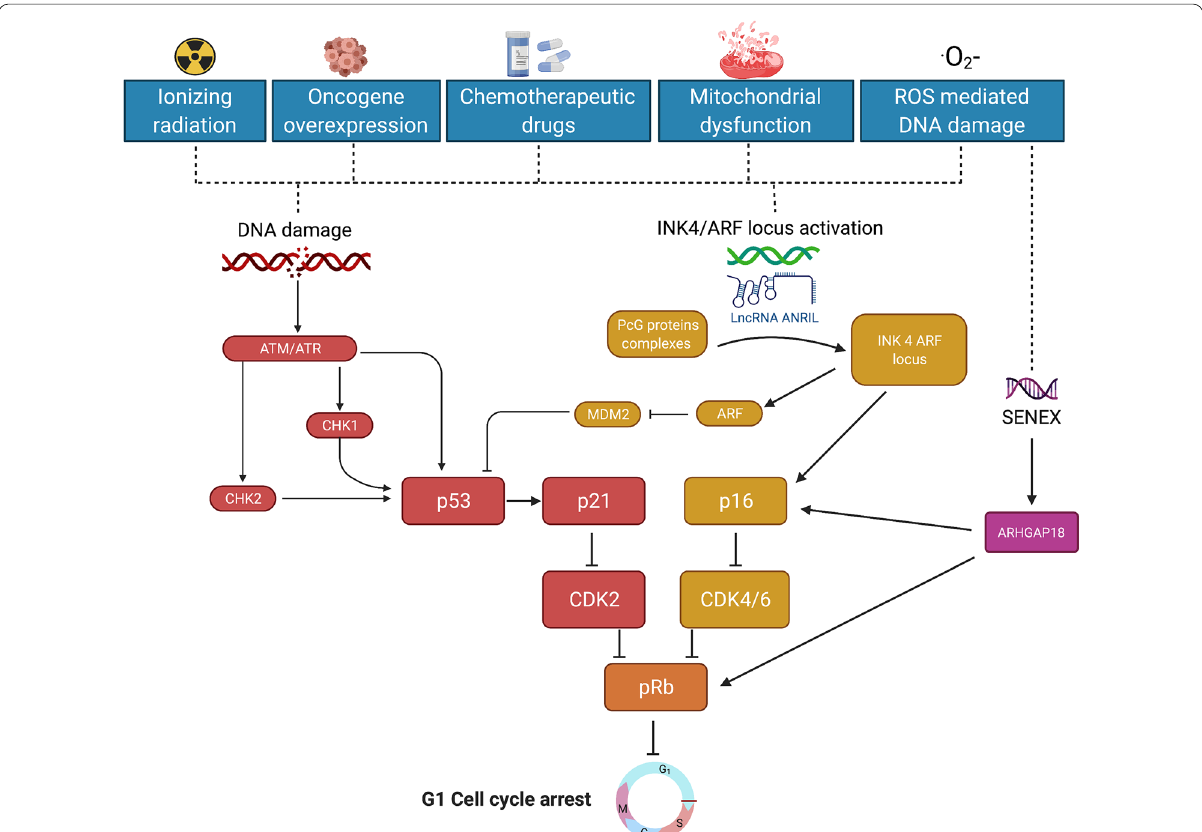
Fig. 5 Main pathways leading to cellular senescence. Mechanisms that drive cellular senescence include the direct activation of the DNA damage response (DDR) through the ATM/ATR pathway and/or of the INK4a/ARF locus through the assembly of PcG protein complexes eventually via the ANRIL scaffolding Lnc RNA. The INK4 family, among which p16, are cyclin‑dependent kinase inhibitors targeting CDK4/6. Ultimately, p53/p21 and p16/Rb pathways are key players driving senescence. ANRIL : antisense non‑coding RNA in the INK4 locus, ARF ADP ribosylation factor, ARHGAP18 (Rho GTPase activating protein 18), ATM ataxia‑telangiectasia mutated, ATR ataxia‑telangiectasia mutated and Rad3 related, CDKs cyclin‑dependent kinases, Chk1 checkpoint kinase 1, Chk2 checkpoint kinase 2, DDR DNA damage response, INK4 inhibitors of CDK4, p16/Rb p16/retinoblastoma protein, PcG polycomb, Lnc RNA long non‑coding RNA, ROS reactive oxygen